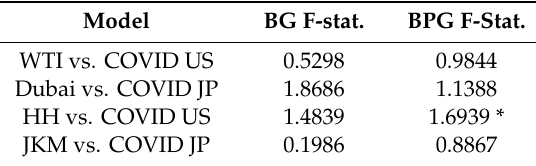
Table 9. Serial Correlation and heteroskedasticity tests.